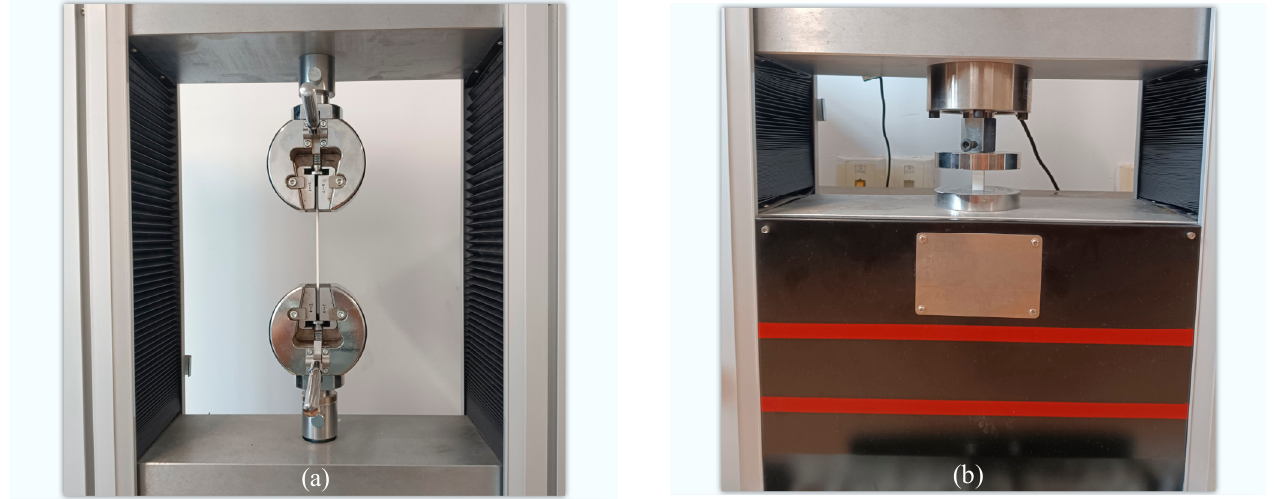
Figure 1. MIT-20 testing machine for mechanical strengths: ( a ) tensile; ( b )